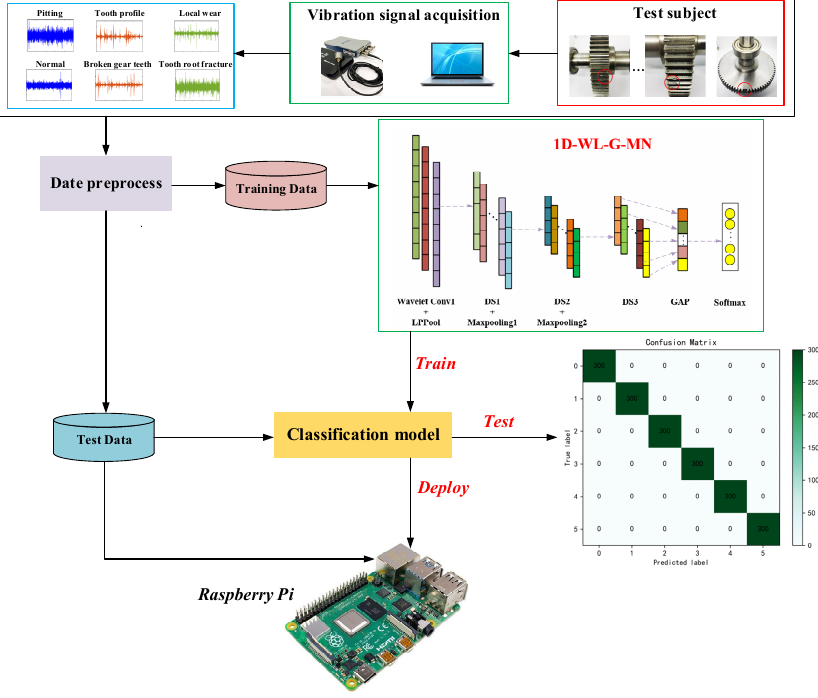
Figure 4. Flow chart.